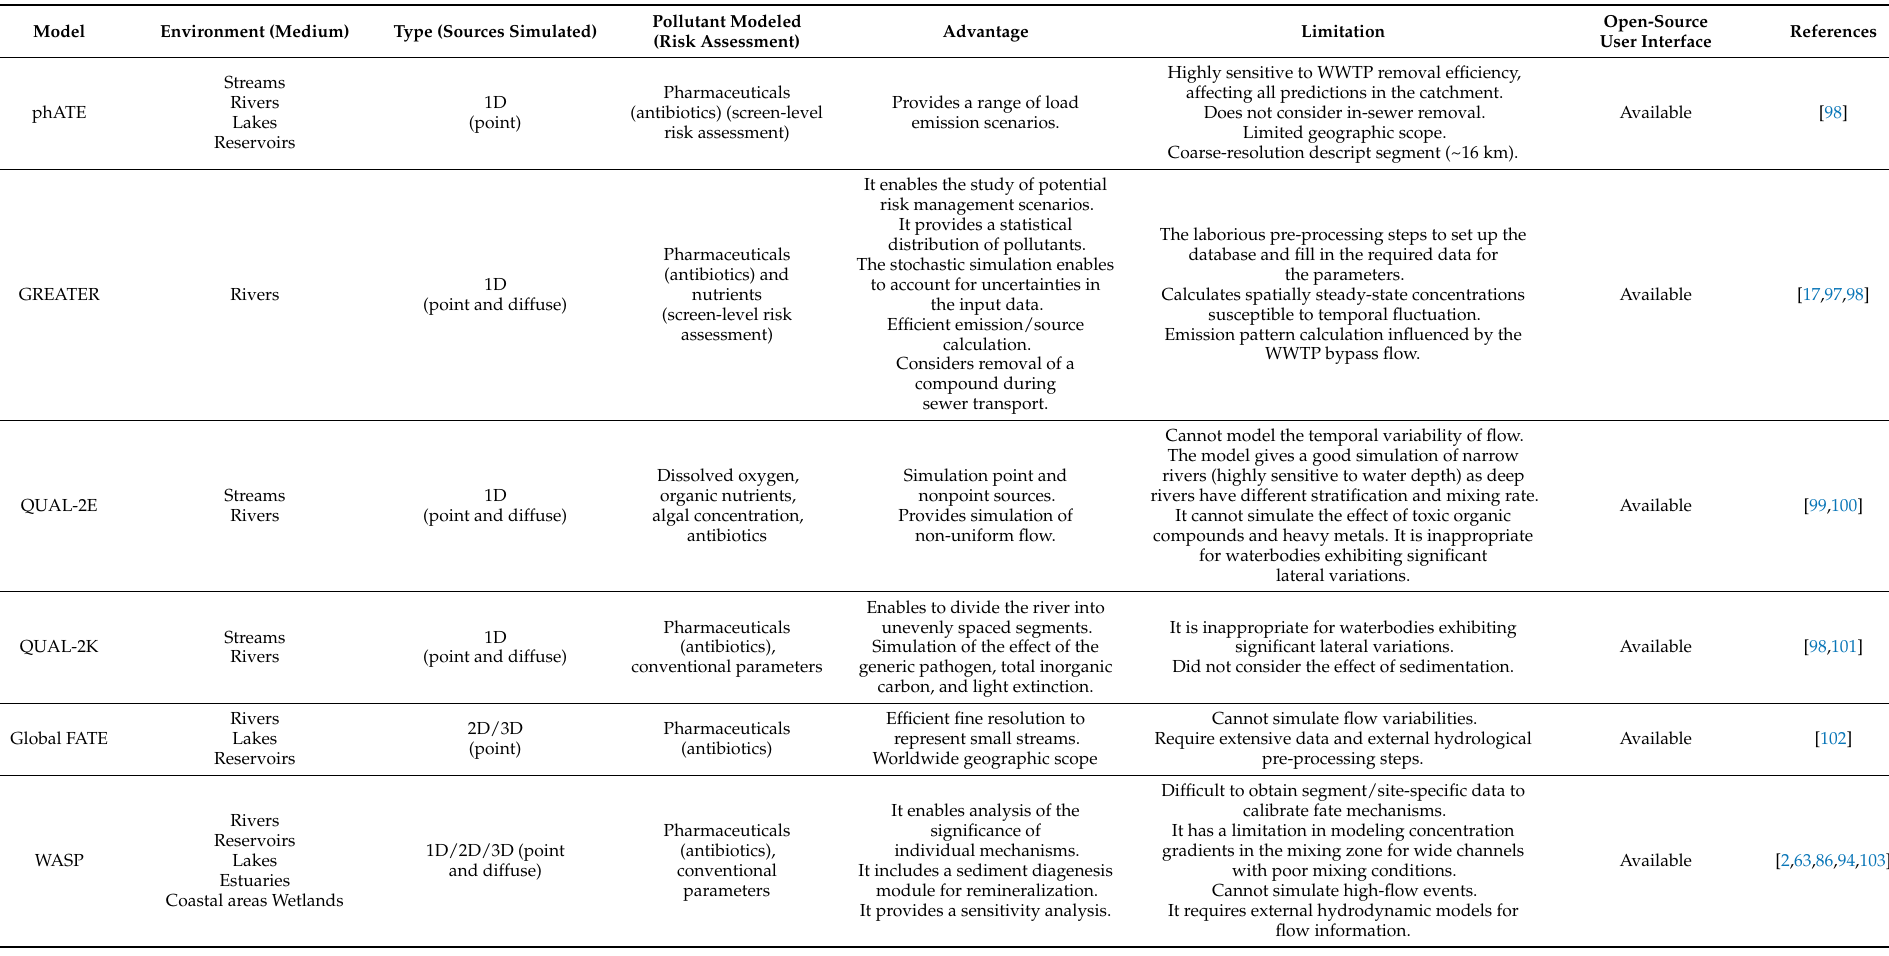
Table 1. Review of environmental antibiotic fate simulation